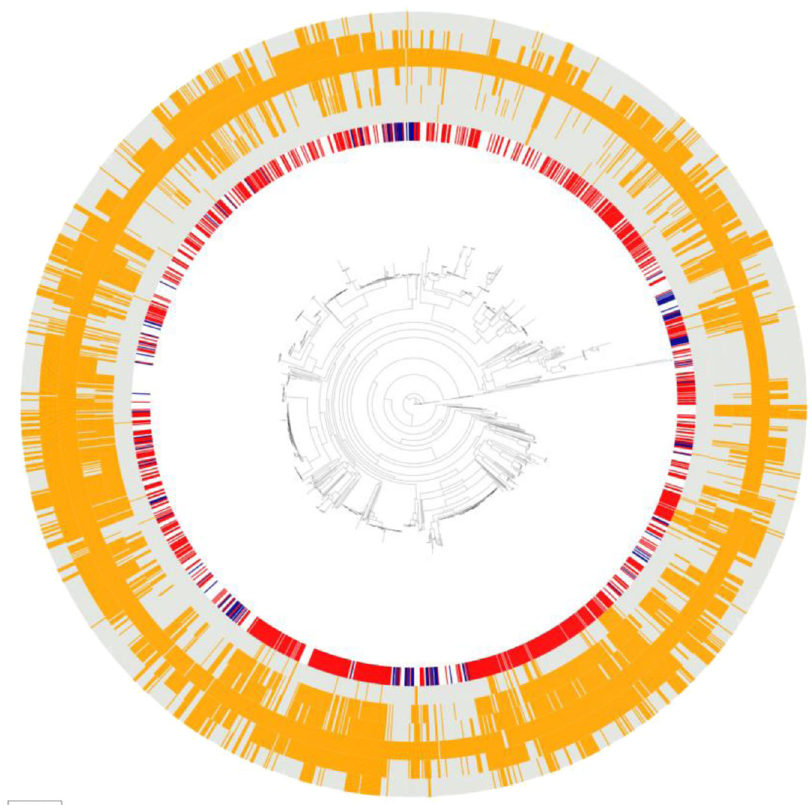
Fig. 6 Collection-wide antimicrobial resistance gene (ARG) patterns of E. faecalis depict abundance of antimicrobial resistance (AMR), also in isolates representing widely different host types. Presence of acquired and apparent intrinsic ARGs is aligned with the species-wide ( n = 2027) reference mapping-based maximum likelihood phylogeny. Inner ring, selected isolation source: hospitalised patient (red) and wild bird (dark blue). Outer rings, presence (orange) and absence (grey) of selected major ARG classes as de fi ned by using Antimicrobial Resistance Identi fi cation By Assembly (ARIBA) v.2.14.4 88 against ResFinder 3.2 database 81 , from inner to outermost ring: vancomycin (glycopeptide), aminoglycosides, macrolides,